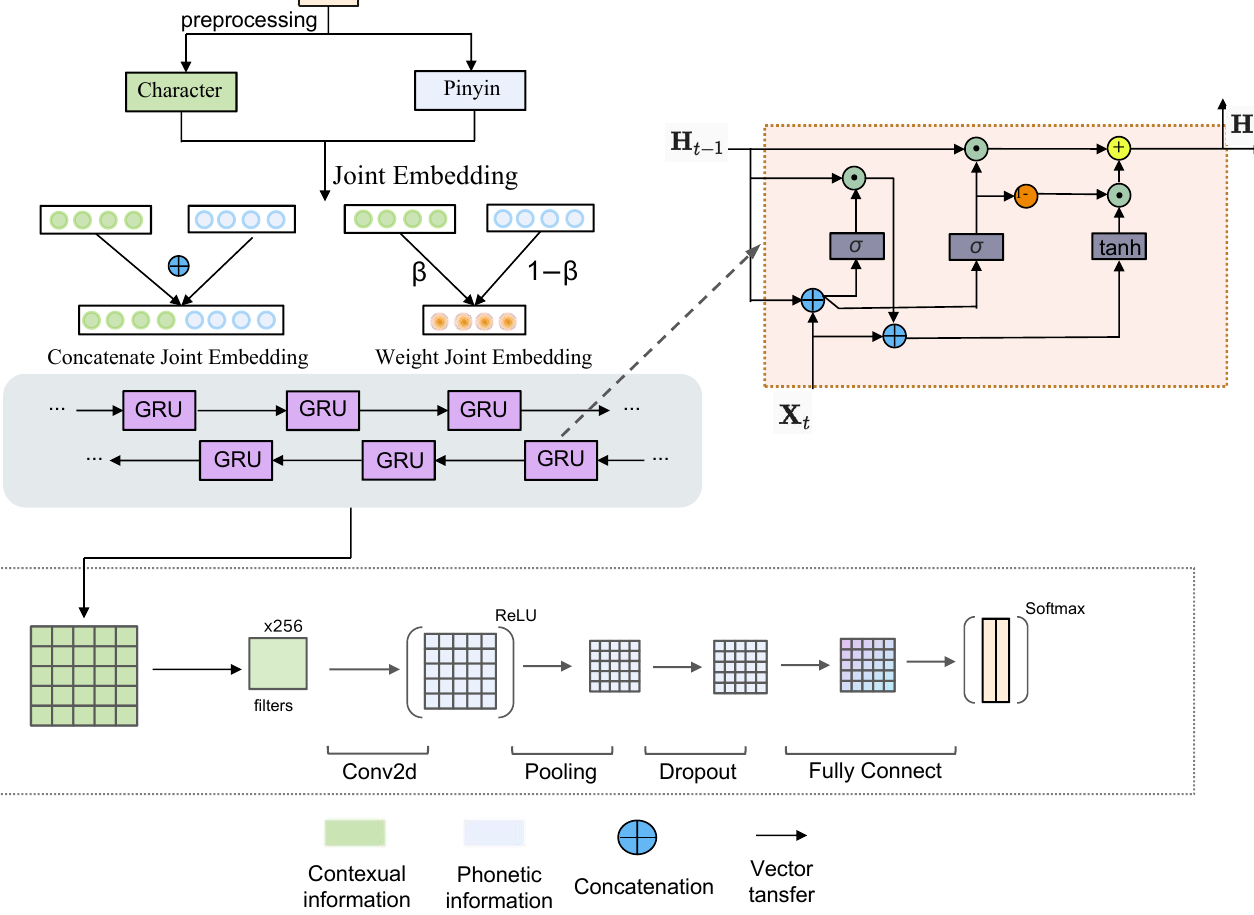
Figure 2. An illustration of the improved BiGRU-CNN with the joint embedding